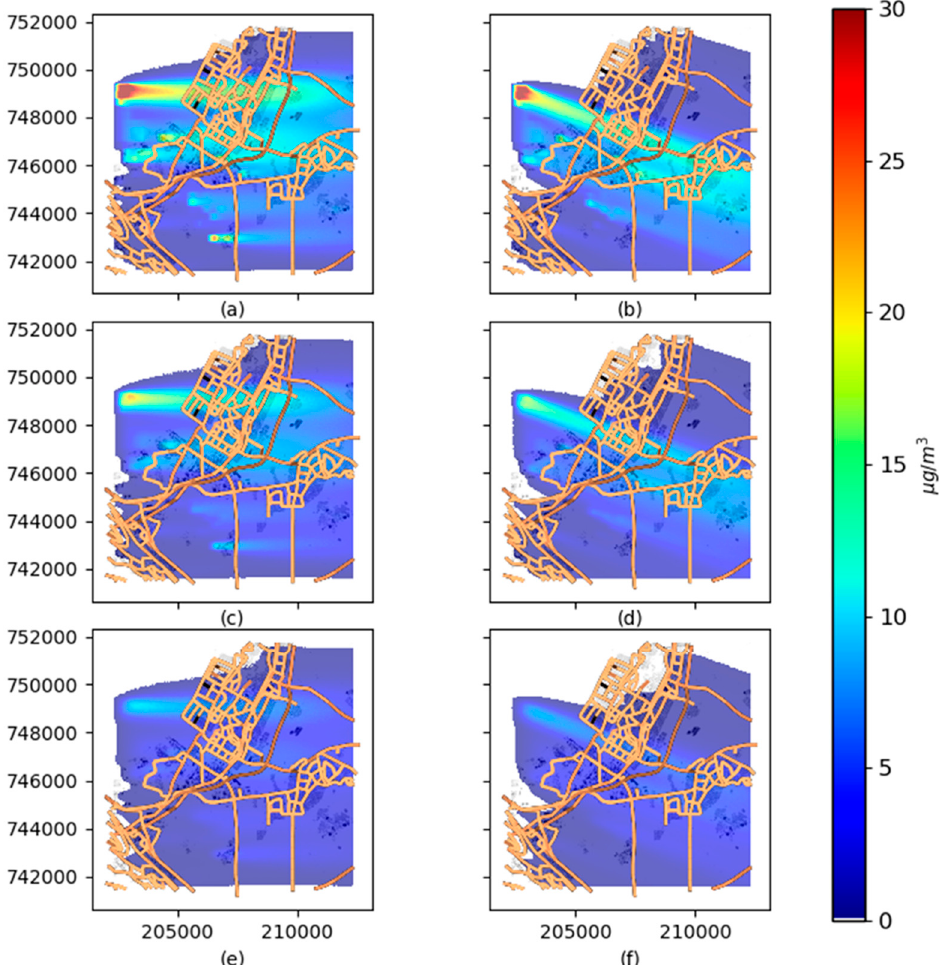
Figure 6. PM2.5 concentrations (in µ g/m 3 ) calculated by the LSM for various heights above ground level. ( a , b ) refer 15 m, ( c , d ) to 45 m, and ( e , f ) to 105 m. The left panels refer to morning conditions and the right to evening. The map coordinates are expressed in ITM (the Israeli Transverse Mercator coordinate system).